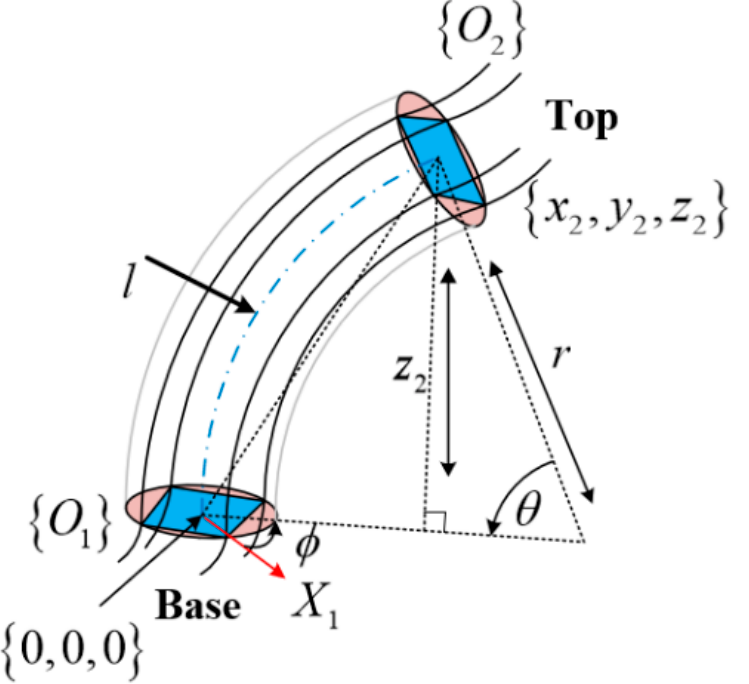
Figure 6. Geometric diagram of the inverse kinematics model of the continuum node. In the second step, the functional relationship between the arc parameters and the length of each PMA is to be determined. In combination with Figure 6, an auxiliary plane N is designed, which passes through the lowest point M at the top of the node { O i + 1 } and is perpendicular to each PMA, see Figure 7a. A straight line is drawn through the point A 1 , A 2 , A 3 , A 4 , O , which is perpendicular to the plane N, and the height of A 1 , A 2 , A 3 , A 4 , O from the plane N is denoted as h 1 φ , h 2 φ , h 3 φ , h 4 φ , h O φ , as shown in Figure 7b.